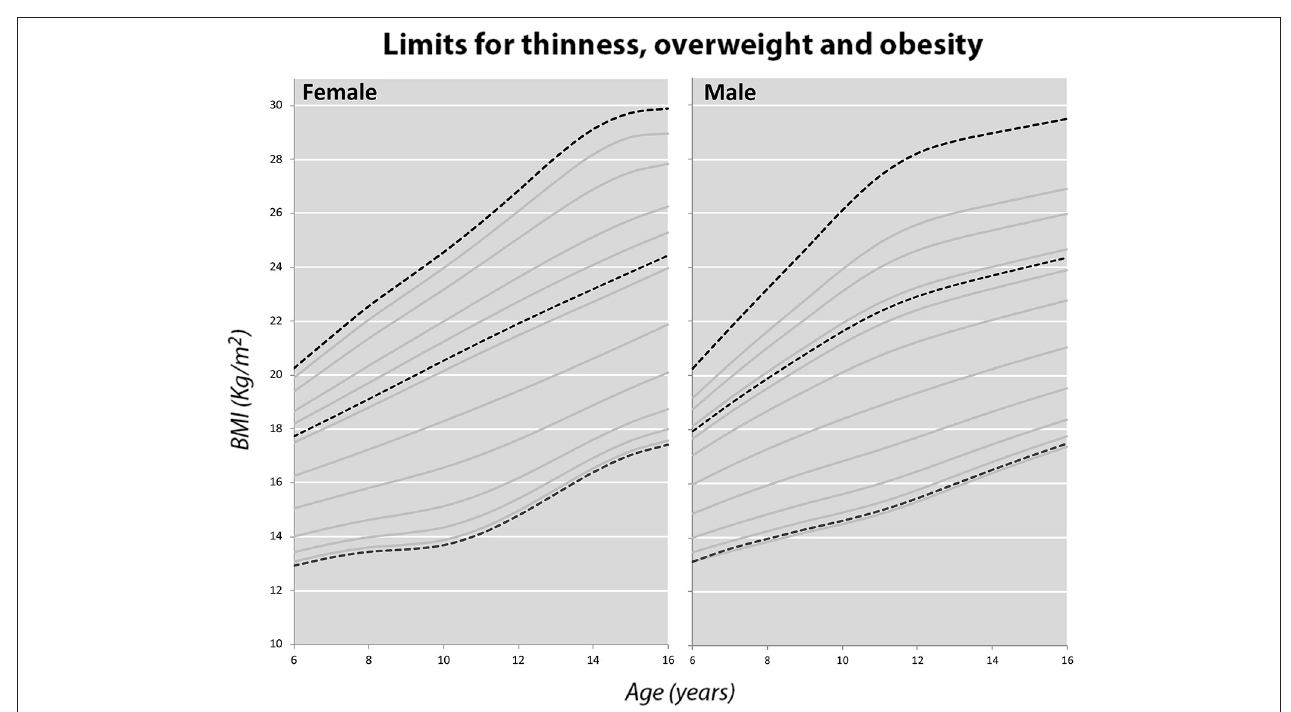
FIGURE 7 | International cut-off points for body mass index by sex for thinness, overweight and obesity.